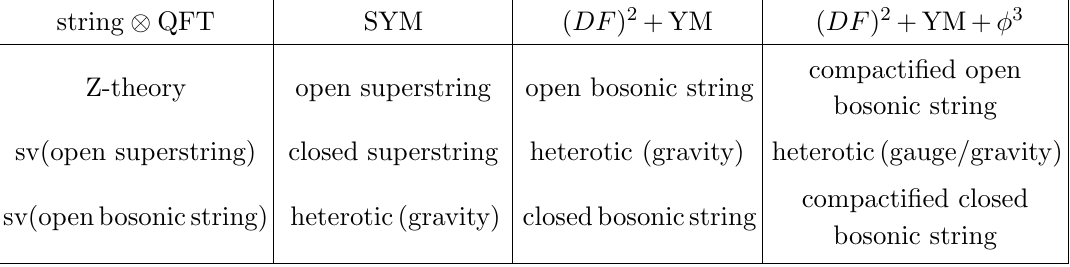
Table 1 . Various known double-copy constructions of string amplitudes. The last two columns of the table are completed in this work. The single-valued projection sv( (cid:15) ) converts disk to sphere